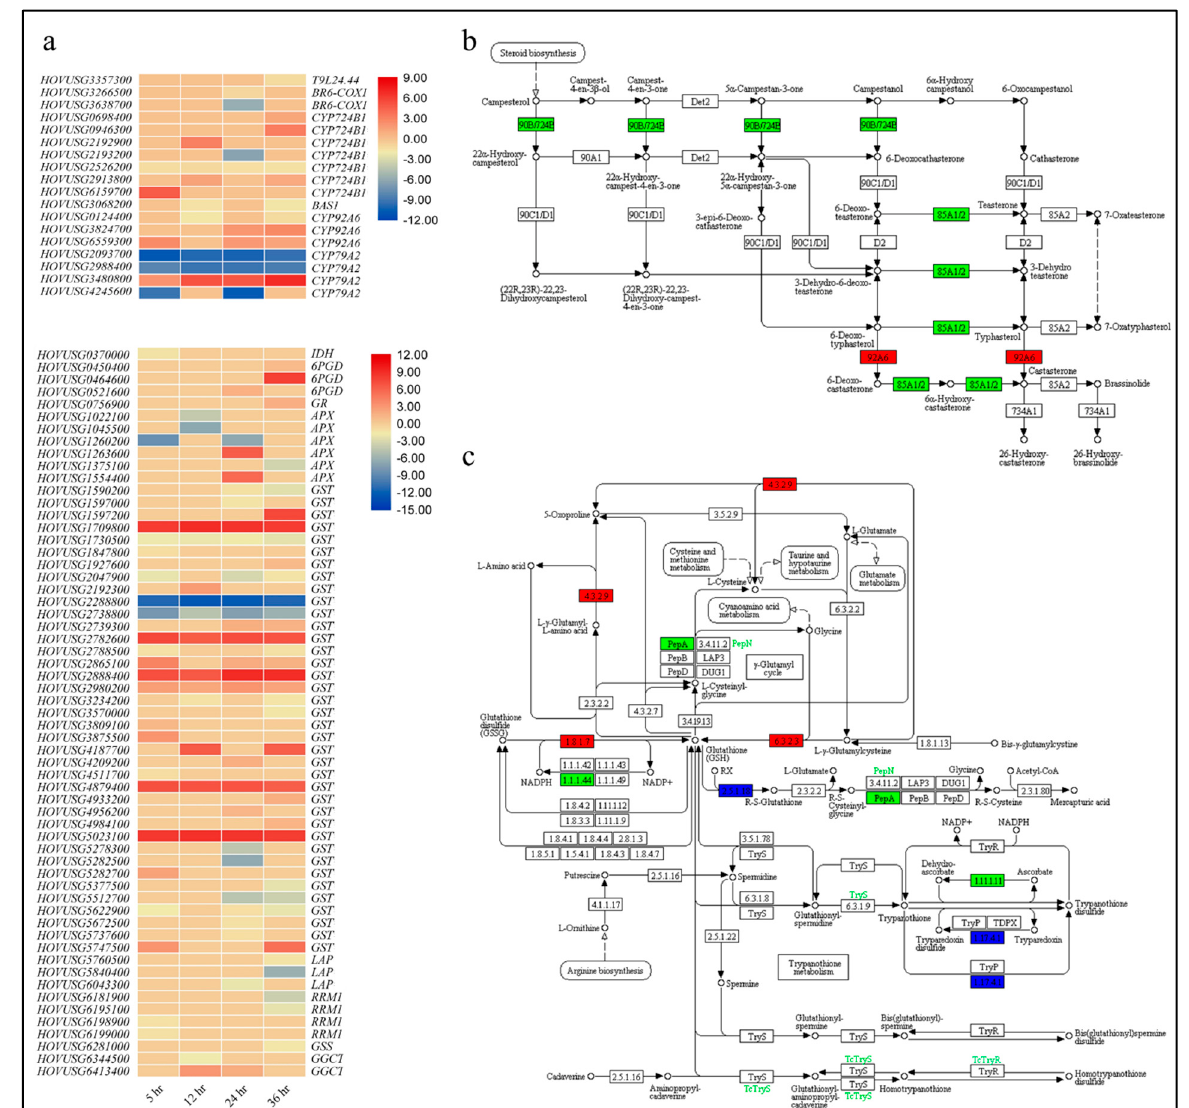
Figure 6. ( a ) Heatmap of log2 FC values of genes related to glutathione metabolism, glucosinolate biosynthesis, and brassi- nosteroid biosynthesis pathways that were differentially expressed in PM infected hulless barley genotypes (XL19 and ZYM1288). ( b ) Differential regulation of brassinosteroid biosynthesis pathway and ( c ) glutathione metabolism pathway between XL19 and ZYM1288 after 24 h of the PM infection. The genes highlighted in green, red, and blue colors represent down-, up-, and up/down-regulated DEGs.